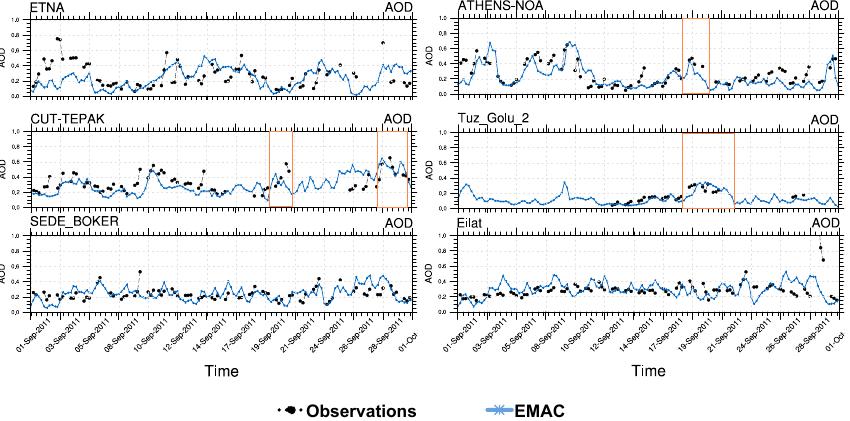
Figure 3. EMAC (T106L31) results (blue line): Aerosol sulfate (SO 2 − 4 ), calcium (Ca 2+ ), total particulate (dry) matter (PM) and AOD (550 nm) compared to observations (black circles) at the EMEP station Ayia Marina and the AERONET station CUT-TEPAK in Cyprus, 2010-2011 (monthly means).